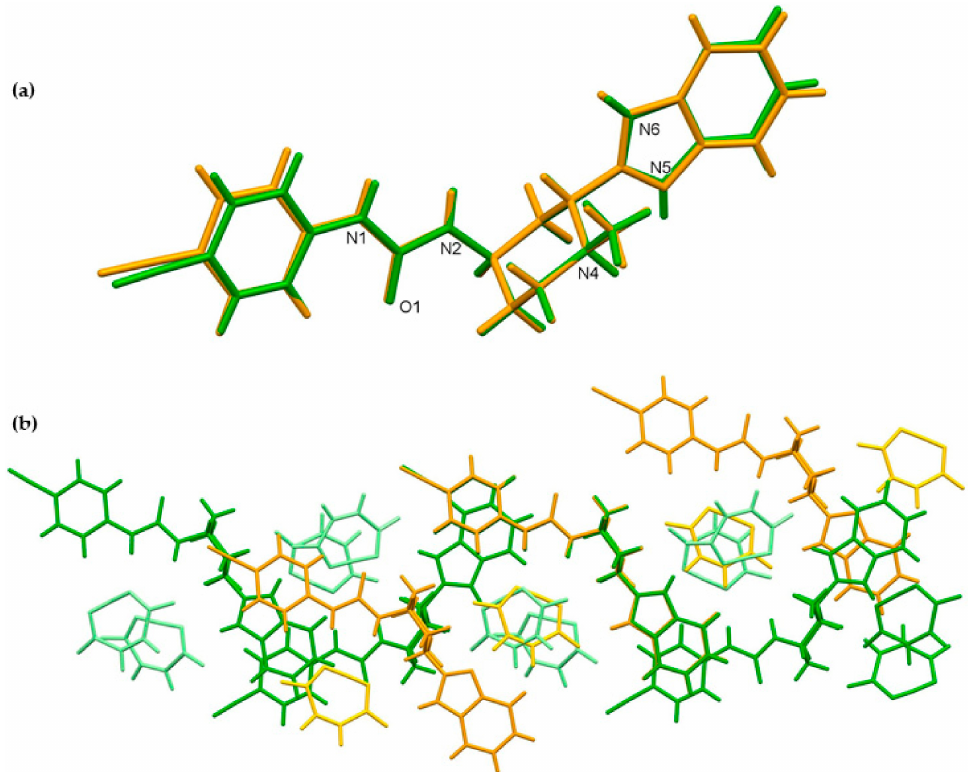
Figure 13. Superposition showing the differences in the conformation of glasdegib monomaleate (orange) and glasdegib dimaleate (green) of ( a ) glasdegib molecule and ( b ) chains along c axes, formed primarily by N–H · · · O interactions. Maleate monoanions are presented in light orange and light green